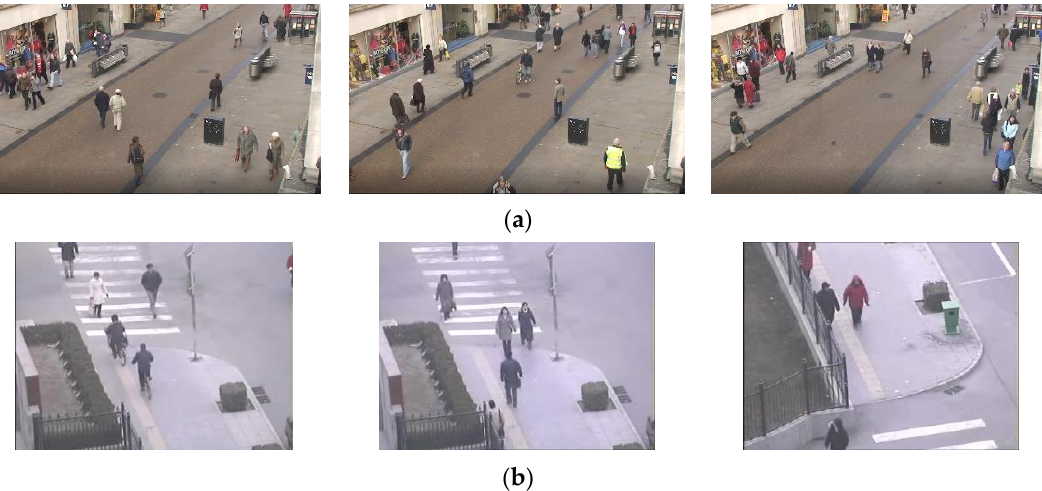
Figure 3. Sample of original frames from the datasets ( a ) Oxford Town Center and ( b ) MCT.